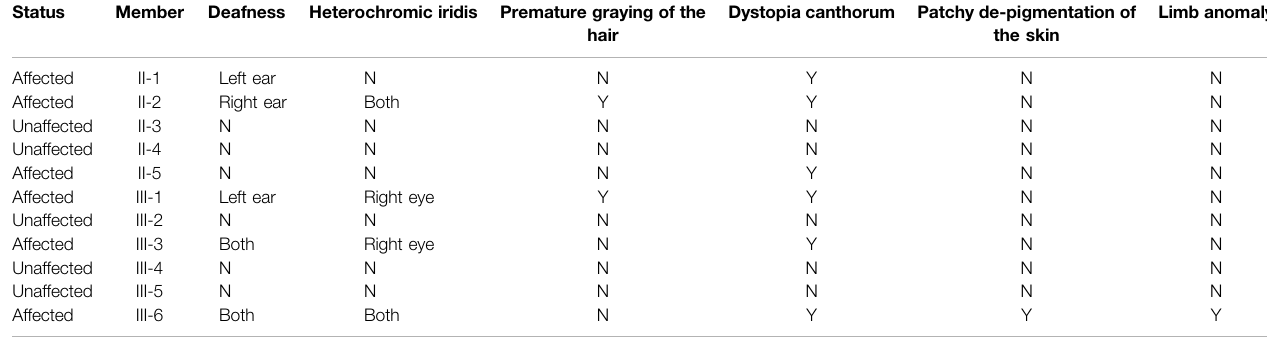
TABLE 1 | Characteristic features of WS3 in Family D.